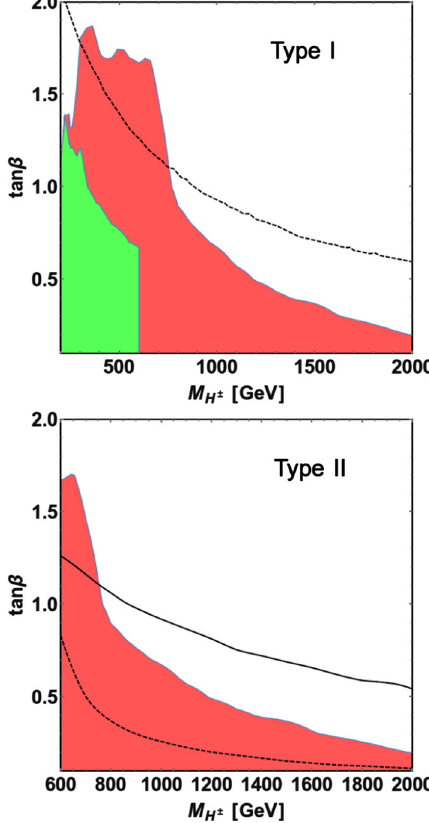
Fig. 4 Exclusion region in Type I and Type II from the upper limits on σ H ± BR ( H + → t ¯ b ) CMS 13 TeV observations are shown in red color. The green color (upper plot) shows the exclusion region from the upper limits on σ( pp → ¯ t ( b ) H + ) CMS 8 TeV observations assuming BR( H + → t ¯ b ) = 1.Theregionbelowtheblackdashedlineisexcluded byBR( B → X s γ )constraintandtheregionbelowthecontinuousblack line in Type II (bottom plot) is excluded by the BR ( B s → μ + μ − ) constraint